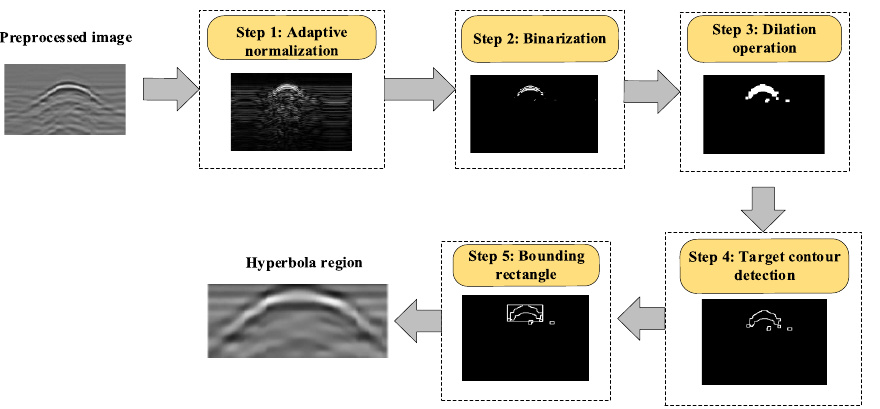
Figure 3. Flowchart of ATRD algorithm for hyperbola region detection.